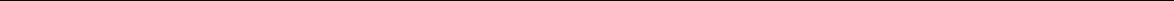
Fig. 3 Eight motifs are enriched at boundaries. a Overview of the strategy used to identify de novo motifs. b Motifs enriched at promoter and non-promoter boundaries (along with Bonferroni-corrected p -values). Two methods were used to estimate enrichment (Methods section): Ame 21 and TRAP 22 . c Clustering of boundaries by motif binding af fi nity (Methods section). Each row represents one boundary. Left panel: clustering of motif binding af fi nity using the TRAP score 22 . Higher scores indicate stronger predicted binding. Dashed lines delineate the clusters. Following panels: using the motif clustering results, we show the heatmaps corresponding to ChIP-seq enrichments for insulator proteins binding the DNA (second panel), other proteins that bind indirectly (third panel) and RNA Pol-II. Last panel shows housekeeping enhancers from ref. 69 . For boundaries at promoters, heatmaps are centered at the gene promoter, for non-promoter boundaries, heatmaps are centered at the nearest CP190 peak within 2000bp. ChIP-seq signal was computed in 50 bp bins for 5000 bp from the center. The scale of each heatmap goes from 1 to 12 for the direct DNA-binding ChIPs and from 1 to the max ChIP-seq value for the indirect binding ChIPs (based on Supplementary Figure 3b). d Relationship between motif presence and ChIP-seq peak fold change at boundaries. Each cell in the matrix contains the mean fold change of all respective ChIP-seq peaks having the motif. For each row, the maximum fold change was scaled to 1. e Pausing index at different boundary-promoters containing one of the boundary motifs. Non-boundary promoters are plotted as